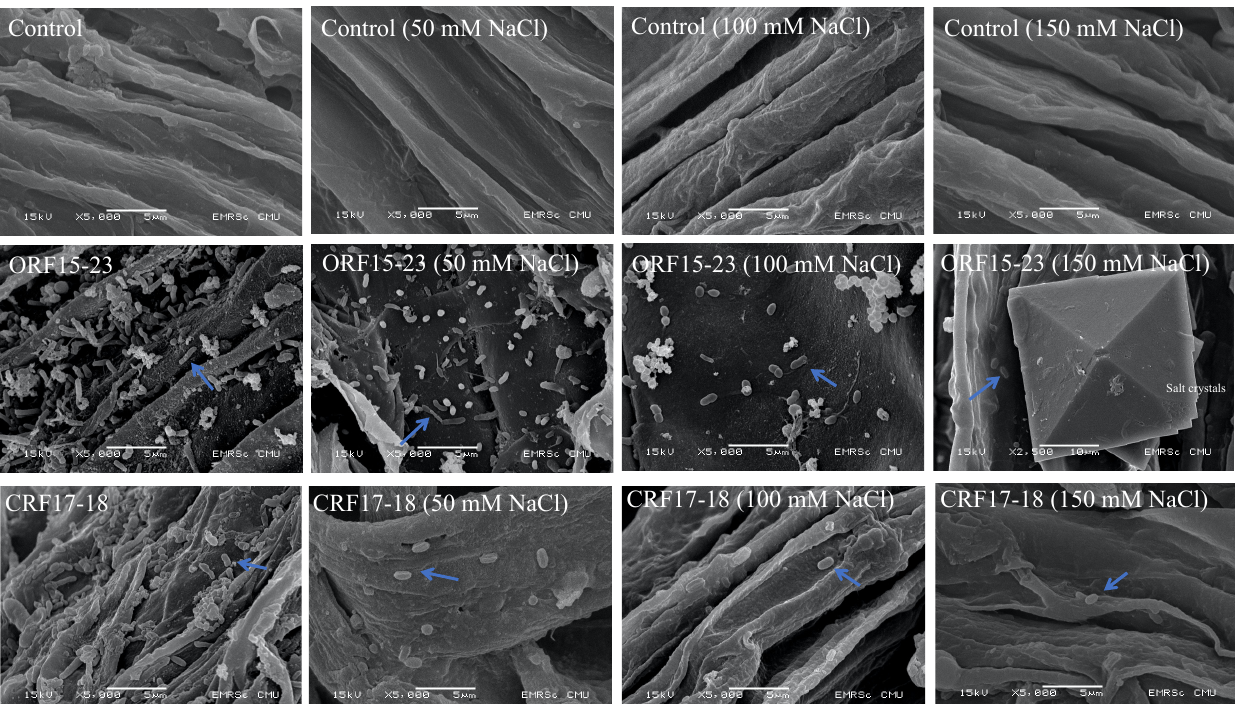
Figure 4. Root colonization of Sinomonas sp. strain ORF15-23 and Bacillus sp. strain CRF17-18 in KDML105 seedlings examined with a field-emission scanning electron microscope (scale bar, 5000 × magnification). The figures are representative of three root samples per treatment.